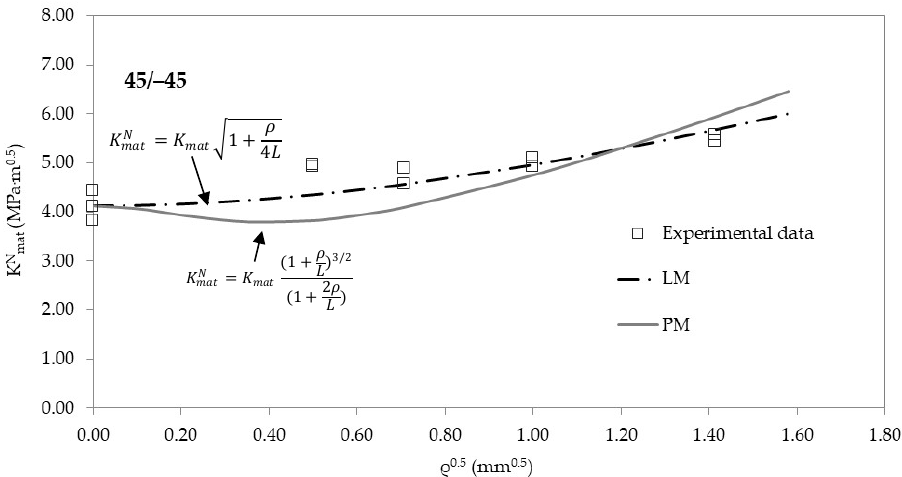
Figure 6. Apparent fracture toughness experimental results in 45 / − 45 raster orientation. Best fit curves provided by the PM and the LM.